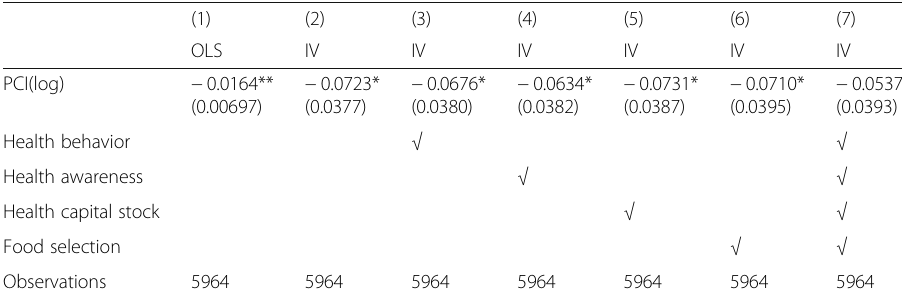
Table 7 Path analysis